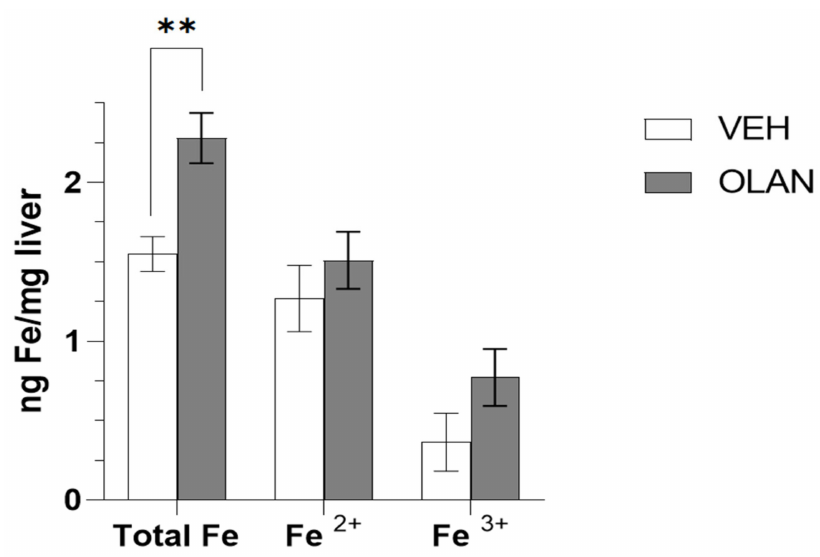
Figure 6. Iron (Fe) concentration in livers of mice treated with vehicle (VEH) or olanzapine (OLAN). Concentrations of iron species were determined in mice treated with VEH ( n = 4) or OLAN ( n = 5) daily for 28 days (5 mg/kg OLAN). ** p <